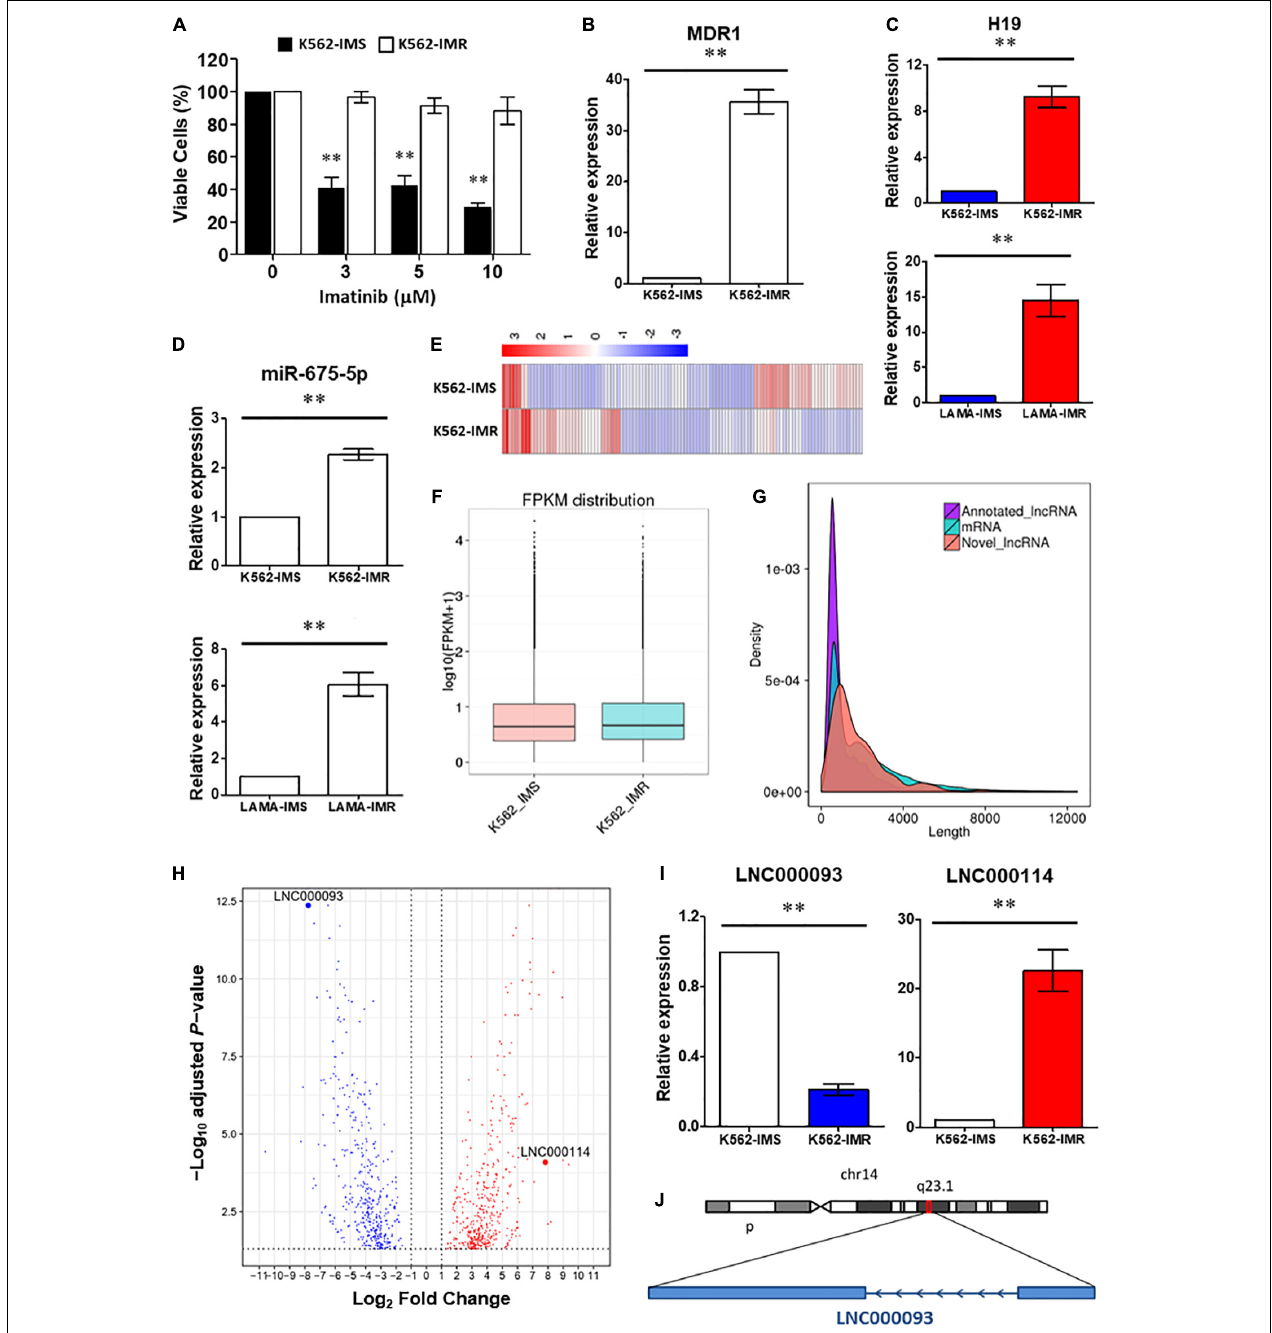
FIGURE 1 | Identification of lncRNAs involved in imatinib-resistant CML cells. (A) Cell viability of K562-IMS and K562-IMR upon imatinib treatment with different dosage was determined by trypan blue exclusion assay ( n = 3). The mean ± SD is shown for the results. ∗∗ P < 0.01. (B) RT-qPCR analysis revealed a significant upregulation of MDR1 expression in K562-IMR relative to K562-IMS ( n = 6). The mean ± SD is shown for the results. ∗∗ P < 0.01. (C,D) The relative expression changes of H19 (C) and miR-675-5p (D) in K562 and LAMA84 were analyzed by RT-qPCR ( n = 4–6). The mean ± SD is shown for the results. ∗∗ P < 0.01. (E) The Heat map reflected differentially expressed genes in RNA-seq for K562-IMS and K562-IMR. (F) The box plot showed the FPKM distribution of K562-IMS and K562-IMR samples in RNA-seq. (G) The density plot showed the length difference of lncRNAs and mRNAs. (H) The volcano plot showed differentially expressed genes of K562-IMR relative to K562-IMS. The horizontal dotted line was the threshold of adjusted P -value < 0.05. The red dots represent upregulated genes, and blue dots represent downregulated genes. The most significant downregulated novel lncRNA LNC000093 and upregulated novel lncRNA LNC000114 were highlighted. (I) RT-qPCR analysis revealed a significant downregulation of LNC000093 and upregulation of LNC000114 in K562-IMR cells relative to K562-IMS cells ( n = 3–6). The mean ± SD is shown for the results. ∗∗ P < 0.01. (J) The novel lncRNA LNC000093 is located on chromosome 14q23.1 and is transcribed in anti-sense direction with 2